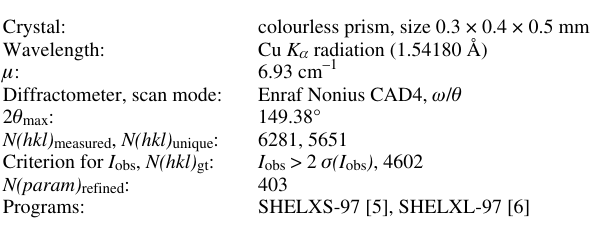
Table 1. Data collection and handling.